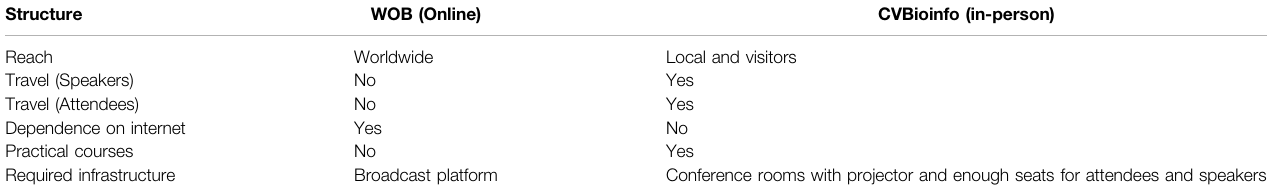
TABLE 1 | Comparison of structure in online and in-person editions. Structure